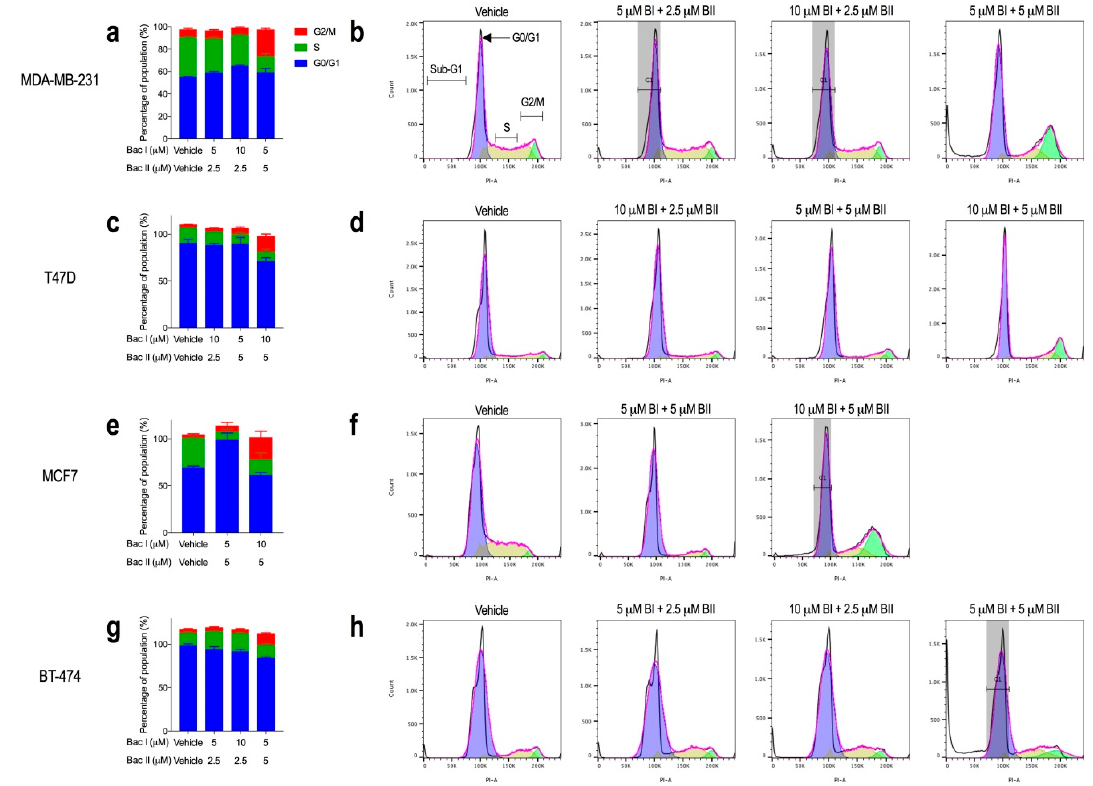
Figure 3. Higher combinations of bac I and II induced G2 / M arrest in breast cancer cell lines. Cells were treated with vehicle or combinations of bac I and bac II for 24 h. Cells were stained with propidium iodide (25 µ g / mL) and bovine pancreas ribonuclease A (40 µ g / mL), and analysed on the BD FACSCanto II cell analyser. The percentage of the population in G0 / G1, S, and G2 / M phases of the cell cycle (left) and representative histograms (right) of propidium iodide-stained DNA, also showing sub-G1 events, for MDA-MB-231 ( a , b ), T47D ( c , d ), MCF7 ( e , f ) and BT-474 ( g , h ) are shown. Data are the mean ± SD of three biological replicates. Two-way ANOVA with multiple comparisons and Bonferroni test was performed for statistical analysis. Grey-shaded regions represent the constraints applied to improve the fit of the Watson model.